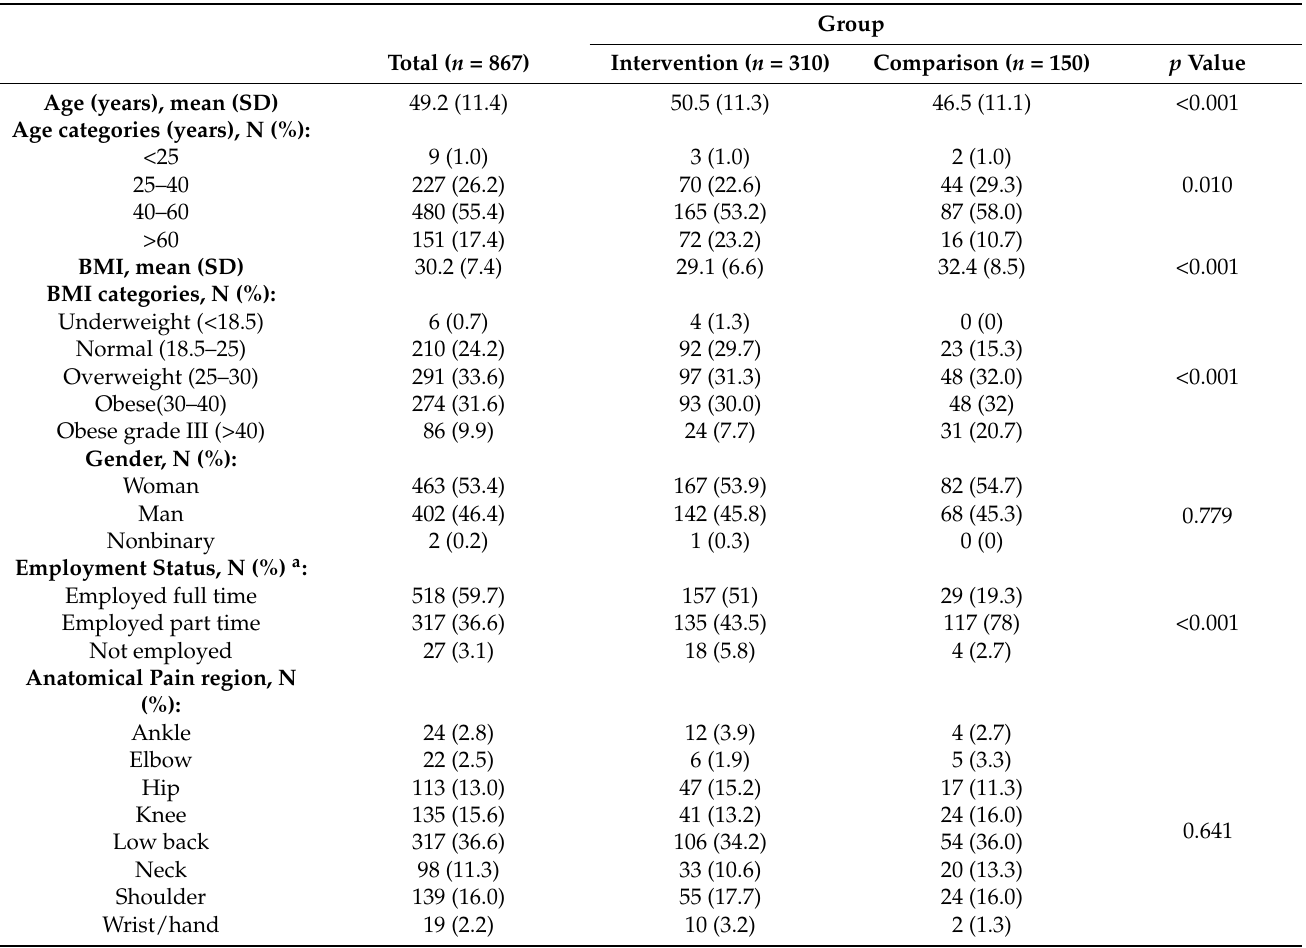
Table 1. Baseline characteristics of study sample and considering intervention and comparison group. Statistical analysis was performed between the intervention and comparison